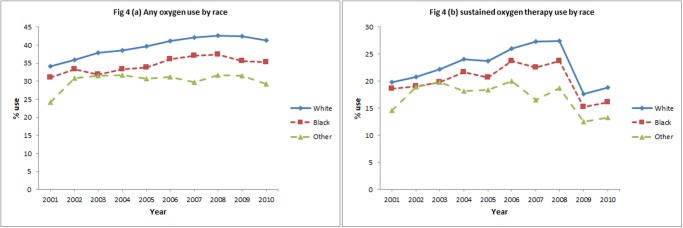
Any oxygen use by race, (a), and sustained oxygen therapy use by race, (b).